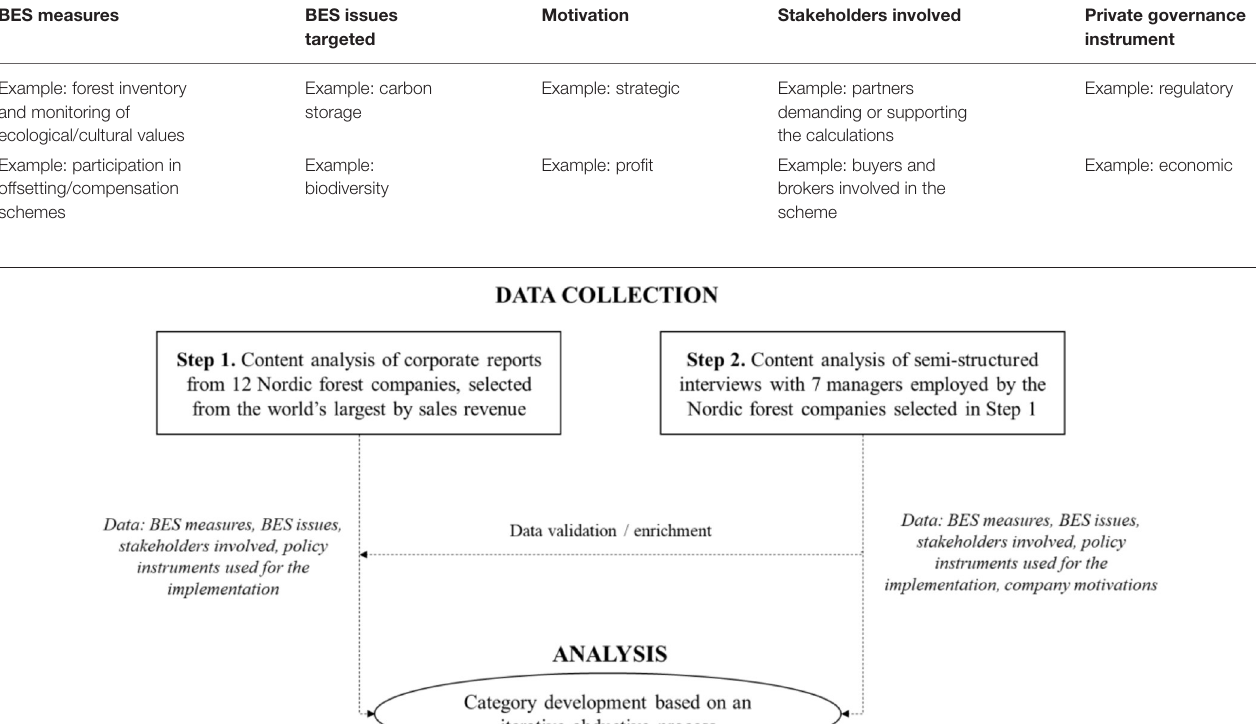
TABLE 2 | An example of the framework at use in this study (for each BES measure), the framework displays the BES issues being targeted, company motivations, the stakeholders involved and the private governance instruments used for the implementation.